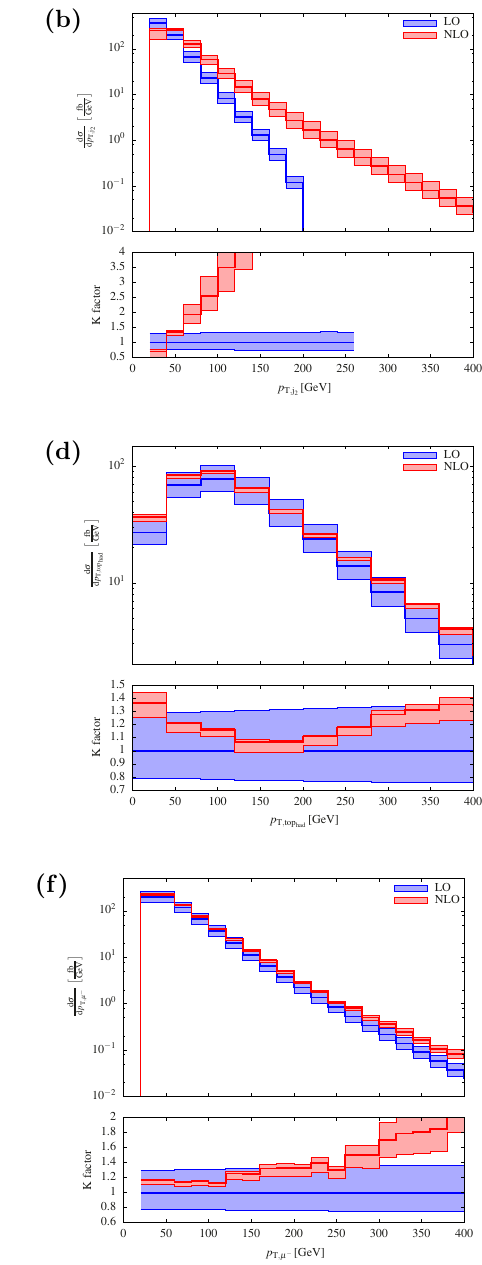
Figure 5. Di(cid:11)erential distributions at a centre-of-mass energy p s = 13 TeV at the LHC for pp (cid:22) (cid:0) (cid:22) (cid:23) (cid:22) b (cid:22) bjj: (a) transverse momentum of hardest jet (top left), (b) transverse momentum of ! the second hardest jet (top right), (c) transverse momentum of the leptonic top quark (middle left), (d) transverse momentum of the reconstructed hadronic top quark (middle right), (e) trans- verse momentum of the hardest bottom jet (bottom left), and (f) transverse momentum of the muon (bottom right). The upper panels show the LO prediction as well as the NLO one. The lower panels display the ratio of the NLO and the LO predictions. The bands correspond to factor-2 scale variations as de(cid:12)ned in eq. (4.9).